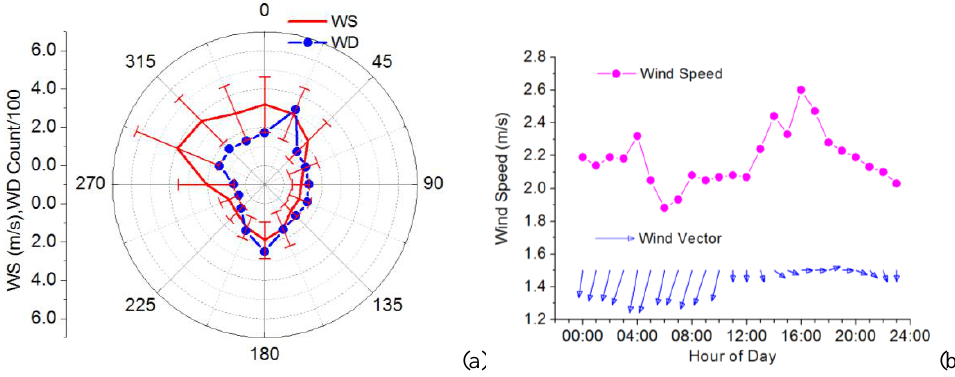
Fig. 2 Wind rose (a) and average diurnal wind speed and vector (b) during the observation period. The average diurnal wind vectors are vector averages calculated from the wind velocities and directions, while the average diurnal wind speeds are arithmetic averages of wind speeds.